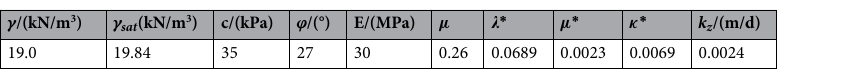
Table 5. Parameters of soil. γ unit weight, γ sat saturated unit weight, c cohesion, ϕ internal friction angle, µ poisson ratio, E elastic modulus, (cid:31) ∗ modified compression index, µ ∗ modified creep exponent, κ ∗ modified rebound coefficient, k z permeability coefficient, in this paper, k z / k x